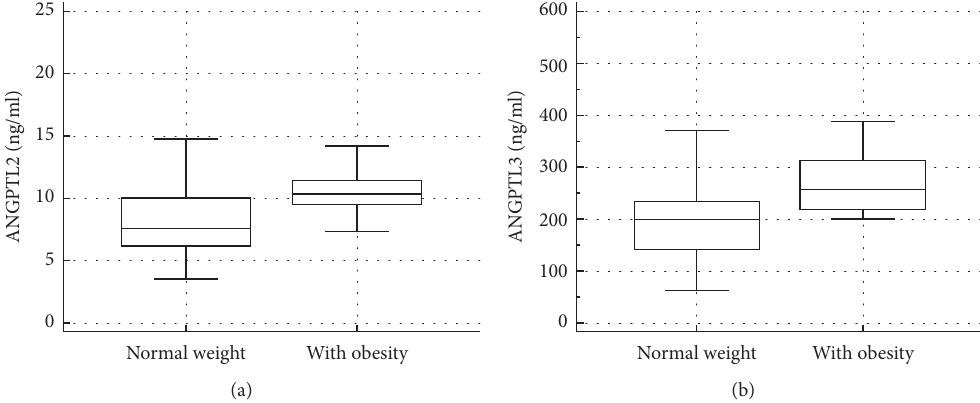
Figure 1: Comparison of (a) ANGPTL2 and (b) ANGPTL3 between subjects with obesity and those with normal